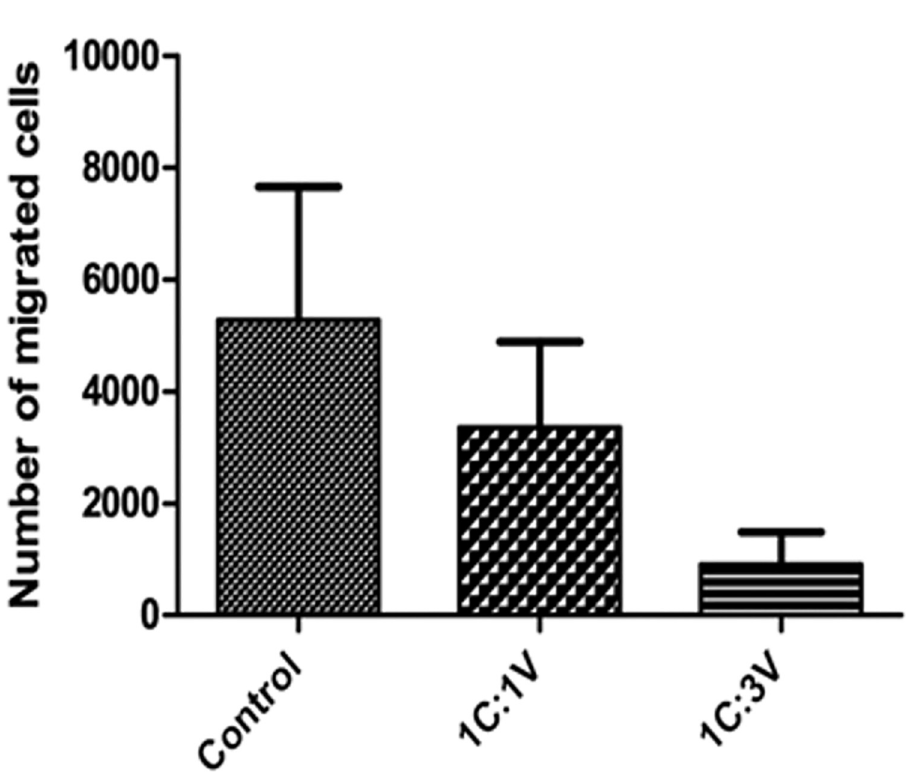
Fig 4. The effect of CVMSCs on MDA-MB231 cell migration using Boyden chamber migration assay. Where the control is C (MDA-MB231), and V is human placental chorionic villi derived MSC. The reduction in the migration response induced by CVMSCs was statistically significant (P = 0.037). Each experiment was repeated 3